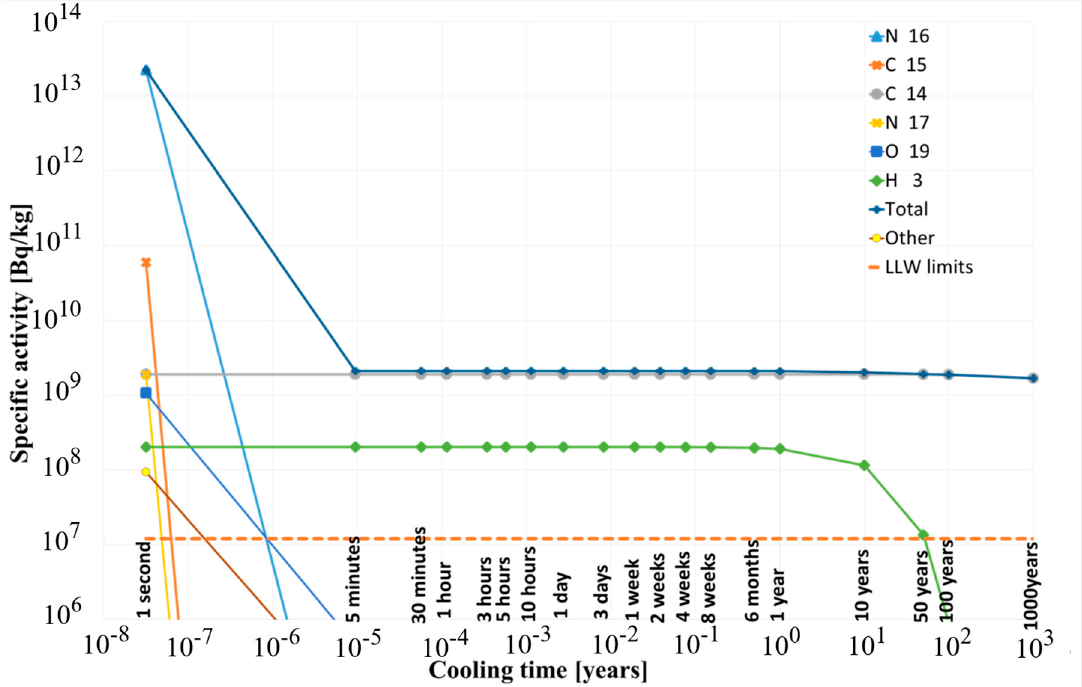
Figure 8. The specific activity of water in the liner and reflector plates (HCPB concept).